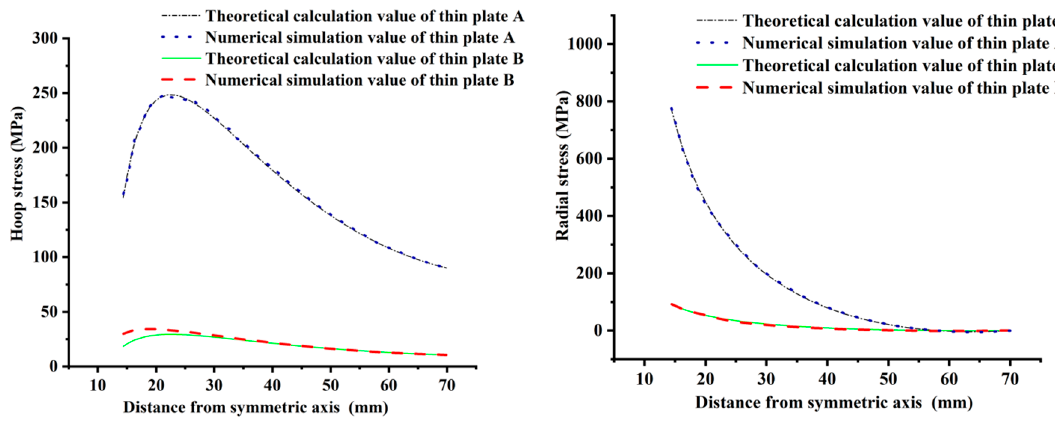
Figure 14. Comparison of theoretical and simulation values of thin plate bending.